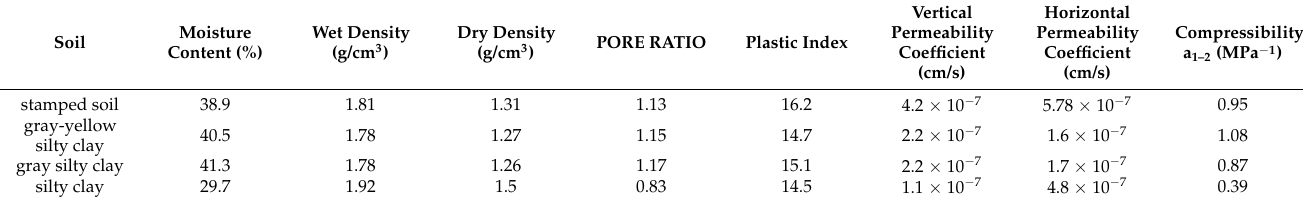
Table 1. Summary of geotechnical test results of soil physical